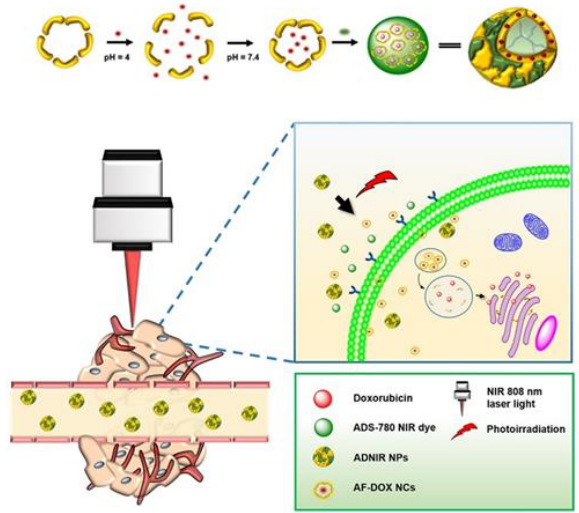
Figure 7. Assembly and in vivo release of grenade-like nanoparticles. Reproduced with permission from ref [60].